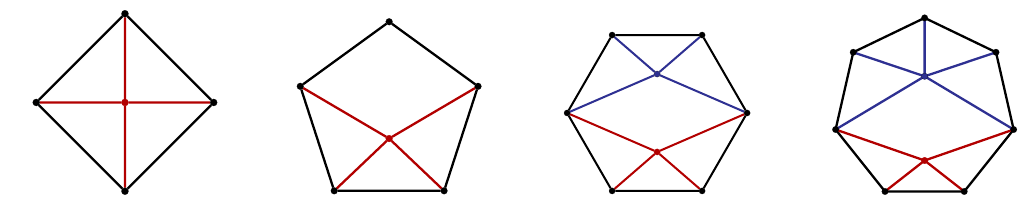
Figure 2 . Disc planar contributions of highlighted-box integrands to four, (cid:12)ve, six and seven (light-like)